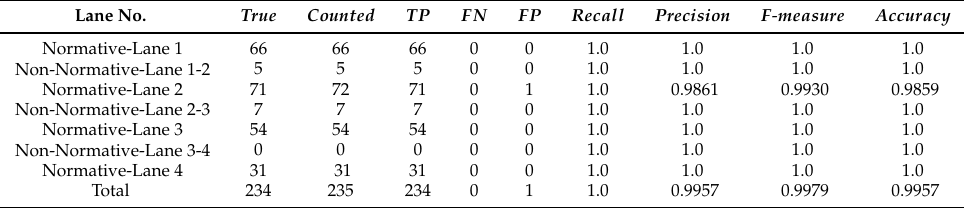
Table 7. The counting results of M-30-HD.